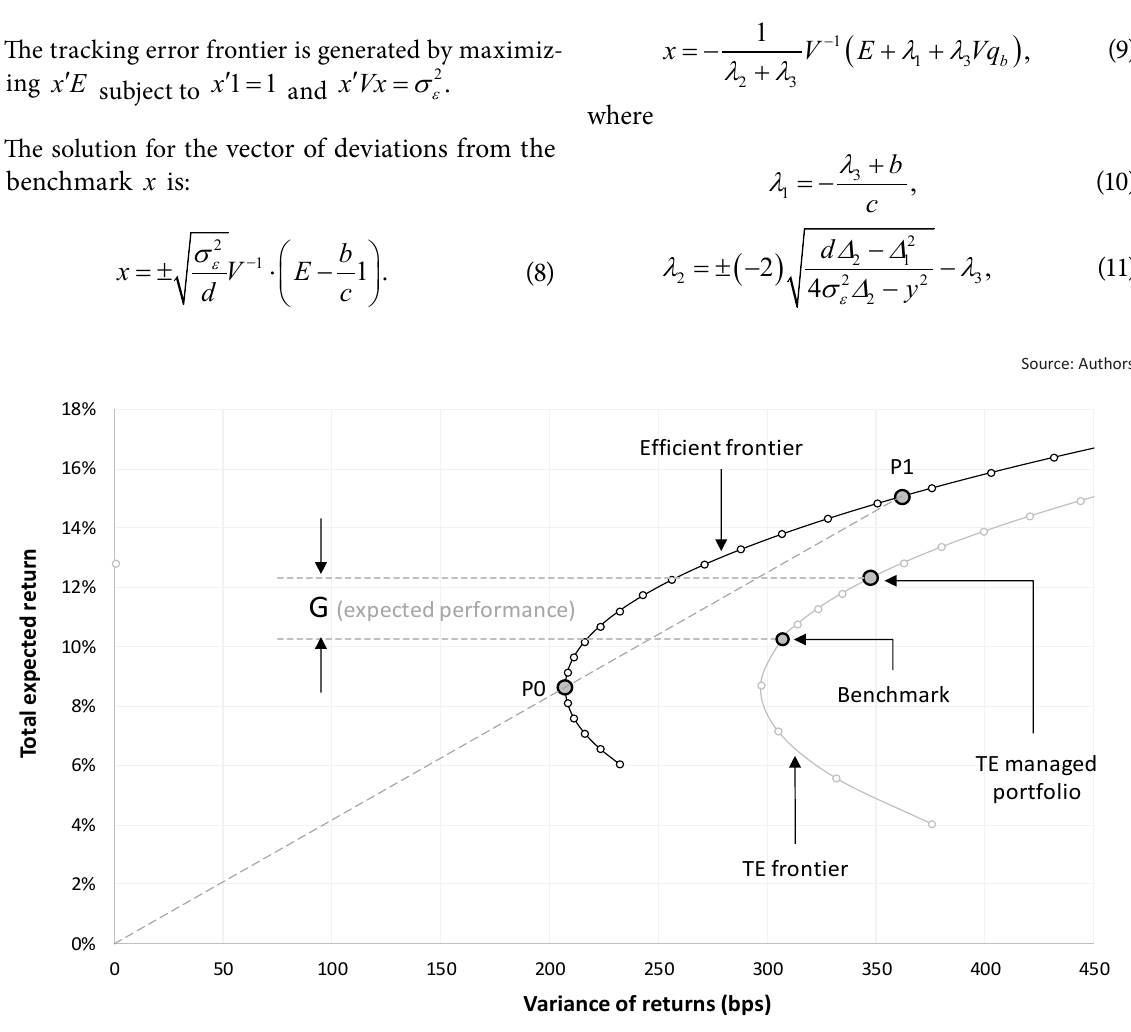
Figure 1. Positions of portfolios